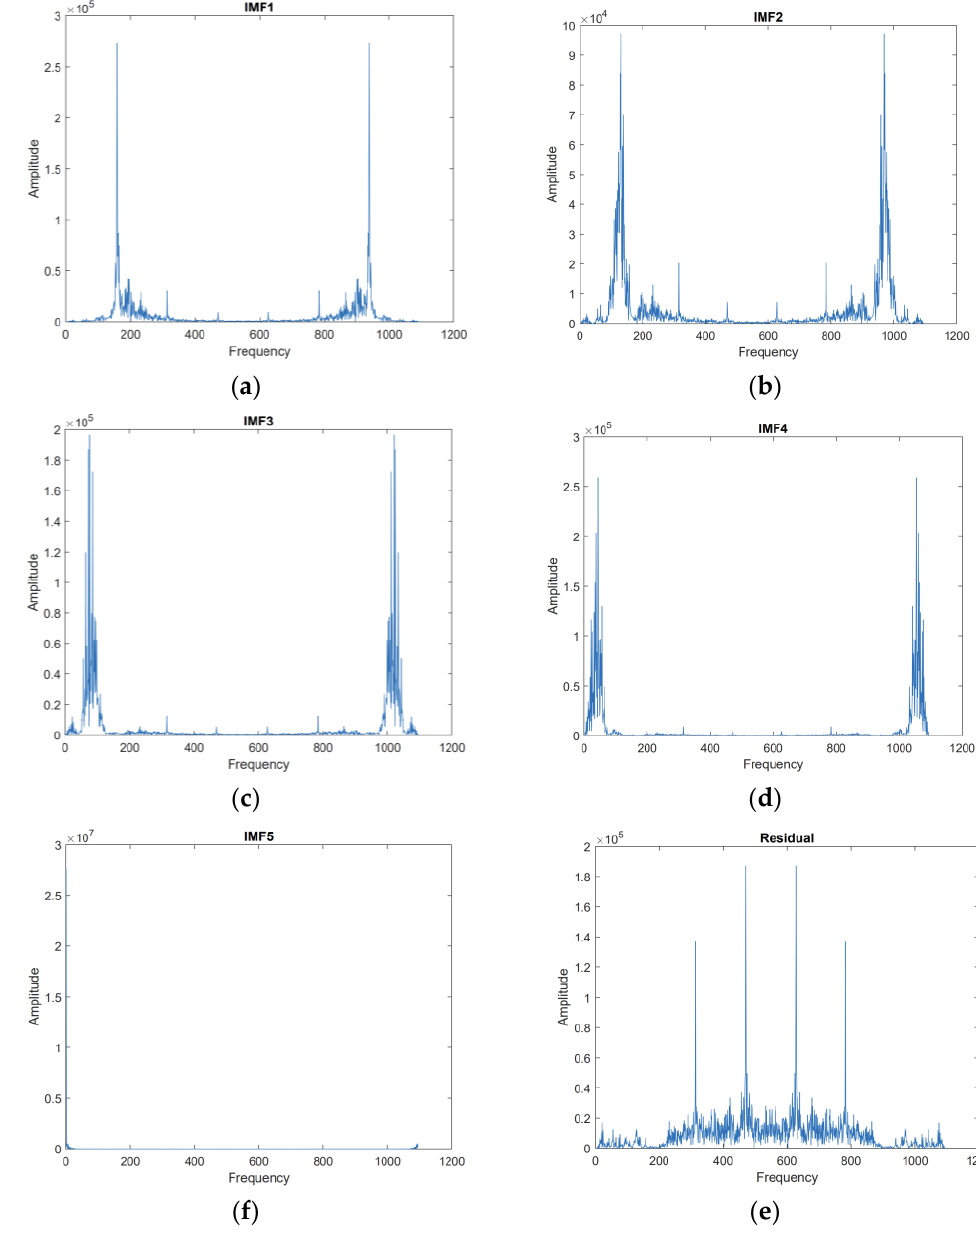
Figure 10. The result after applying FFT to all IMFs and residuals. ( a ) IMF1; ( b ) IMF2; ( c ) IMF3; ( d ) IMF4; ( e ) IMF5; ( f ) residual.